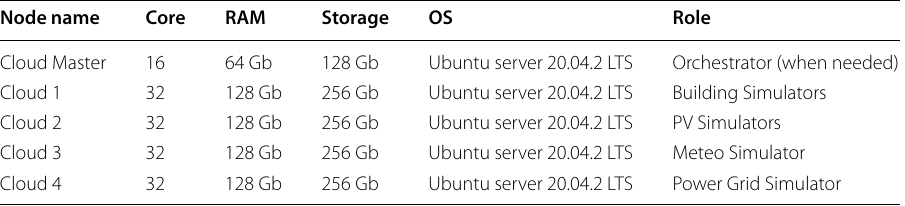
Table 2 Summary of the computational nodes used in the